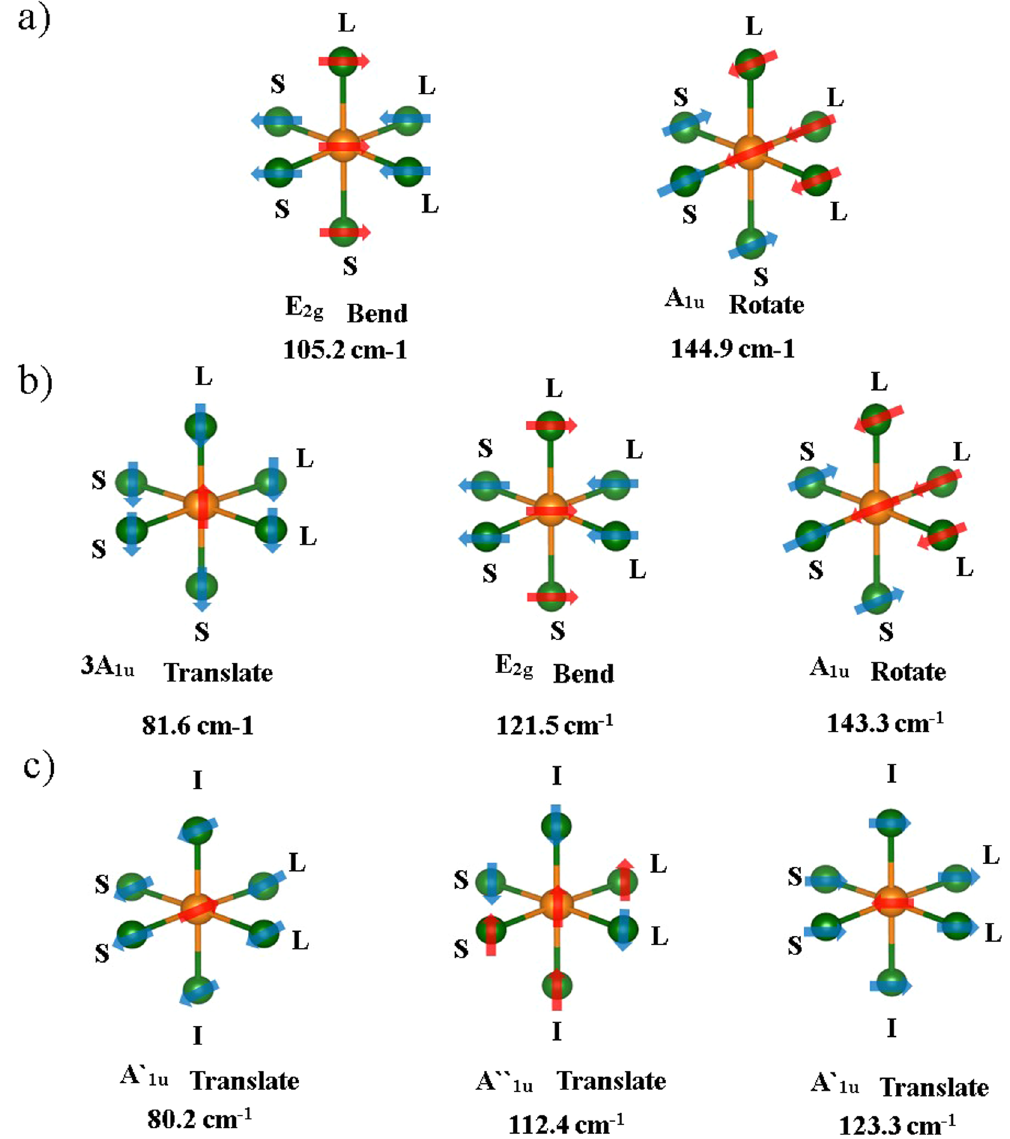
Figure 6. Positions, atomic vibrations, and symmetries of Raman-active modes as predicted by DFT: ( a ) R3m, ( b ) P1, and ( c ) Cm. The Fm3m structure has no Raman-active modes. Movement directions are indicated by arrows and opposite directions are distinguished by red and blue colors. The calculated peak positions and symmetries are shown on the